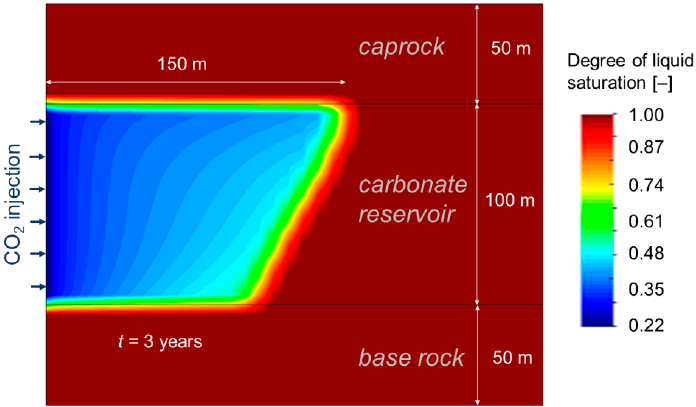
Figure 7. CO 2 plume after 3 years of injection presenting a subvertical CO 2 -brine boundary 150 m away from the injection well.